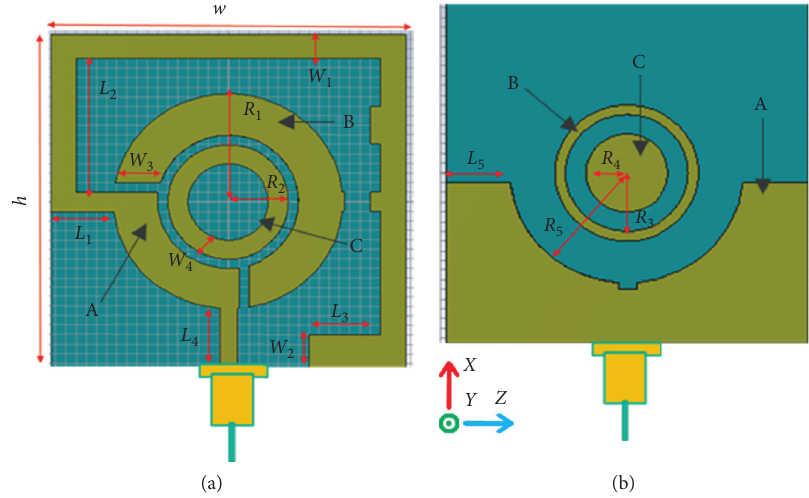
Figure 3: Antenna conception parameters: (a) top and (b) bottom. Each length is a parameter for the antenna